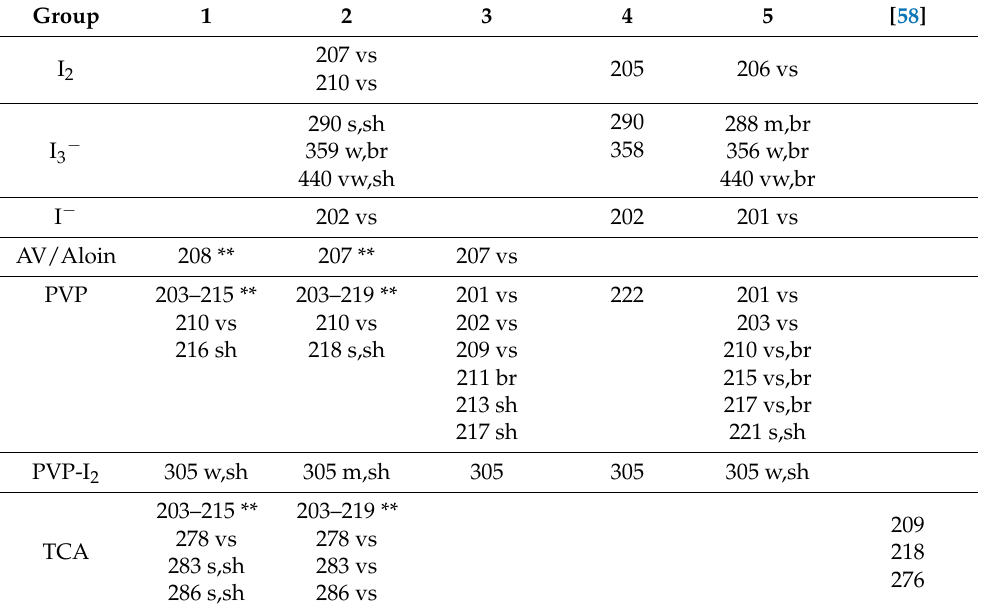
Table 2. UV-vis absorption signals in the samples AV-PVP-TCA (1), AV-PVP-TCA-I 2 (2), AV-PVP